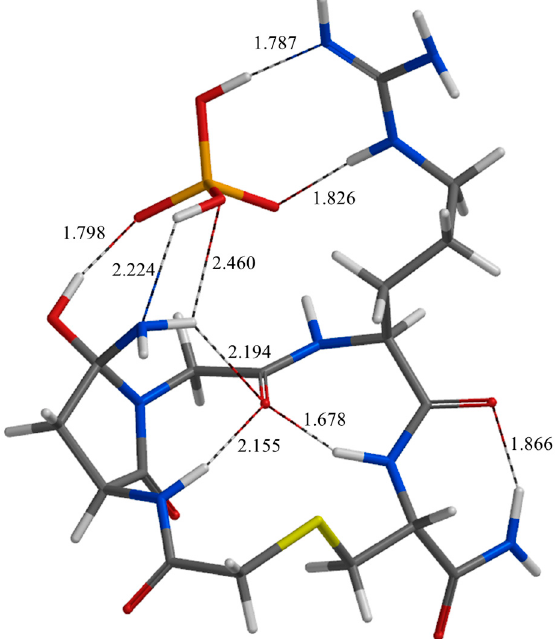
Figure 10. The geometry of TS4 (transition state 4) connecting IC3 (Figure 9) and IC4 (Figure 11). Selected interatomic distances are shown in Å. Grey: carbon; white: hydrogen; blue: nitrogen; red: oxygen; orange: phosphorus; yellow: sulfur.